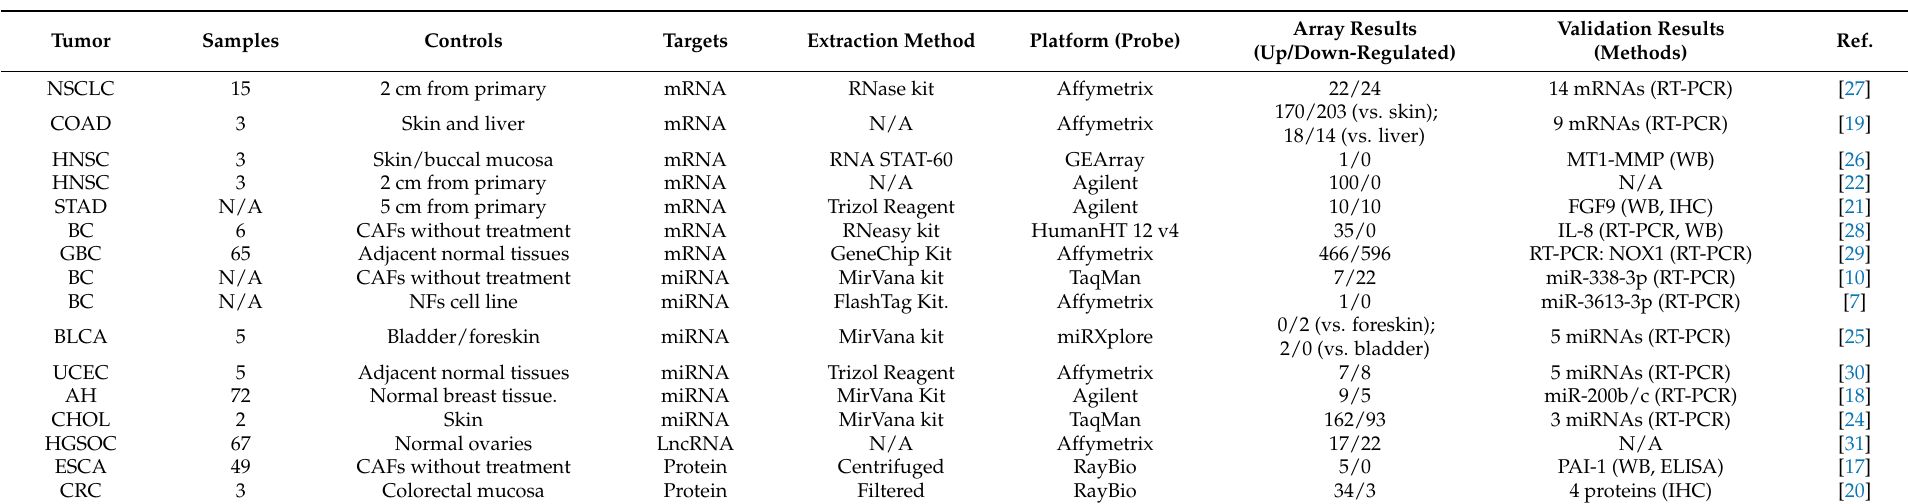
Table 1. Biochips targeting cancer-associated fibroblasts in different human